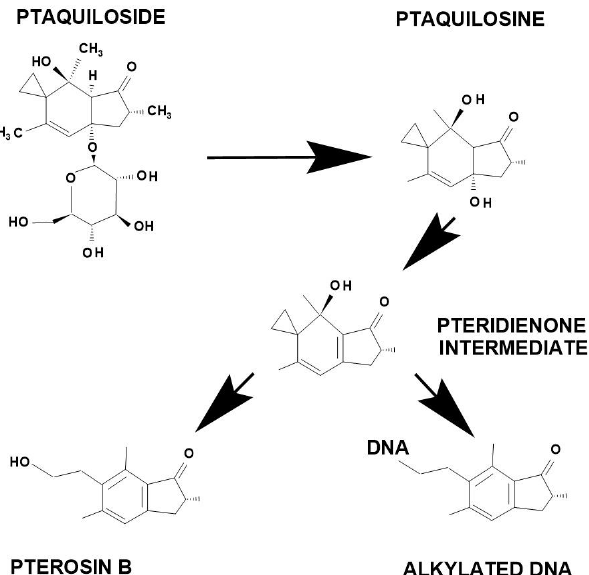
Figure 5. The possible metabolic ways of ptaquiloside (PTA) transformations. From the dienone intermediate (pteridienone) the non-toxic pterosin B can be produced, or the DNA molecule can be alkylated, which can lead to carcinogenesis through mutations.